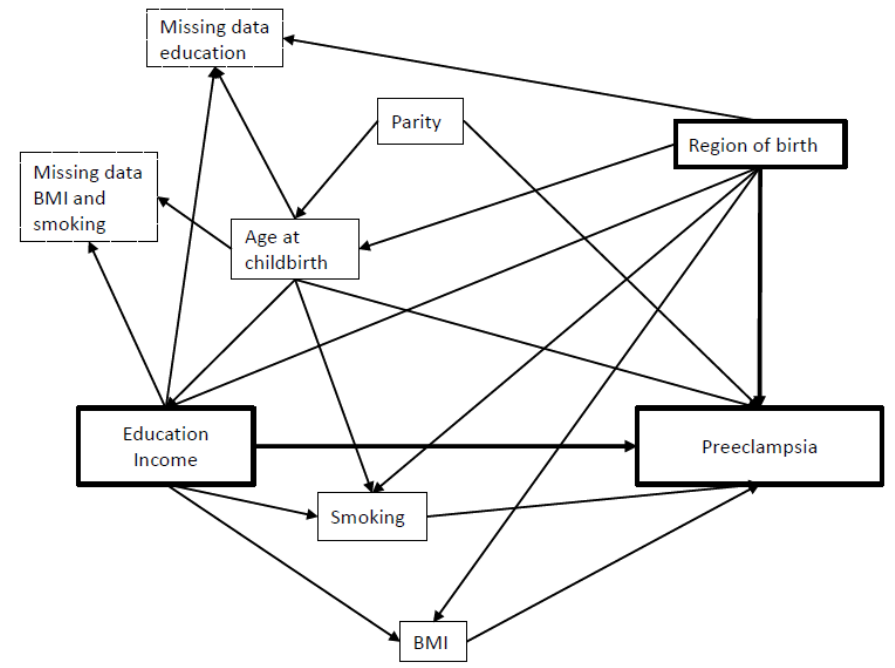
Figure 2. Directed Acyclic Graph conceptualizing the relationship between variables. Missing Data